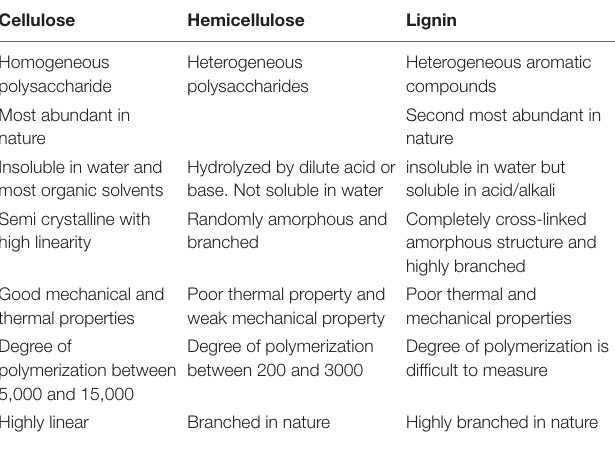
Heterogeneous aromatic compounds